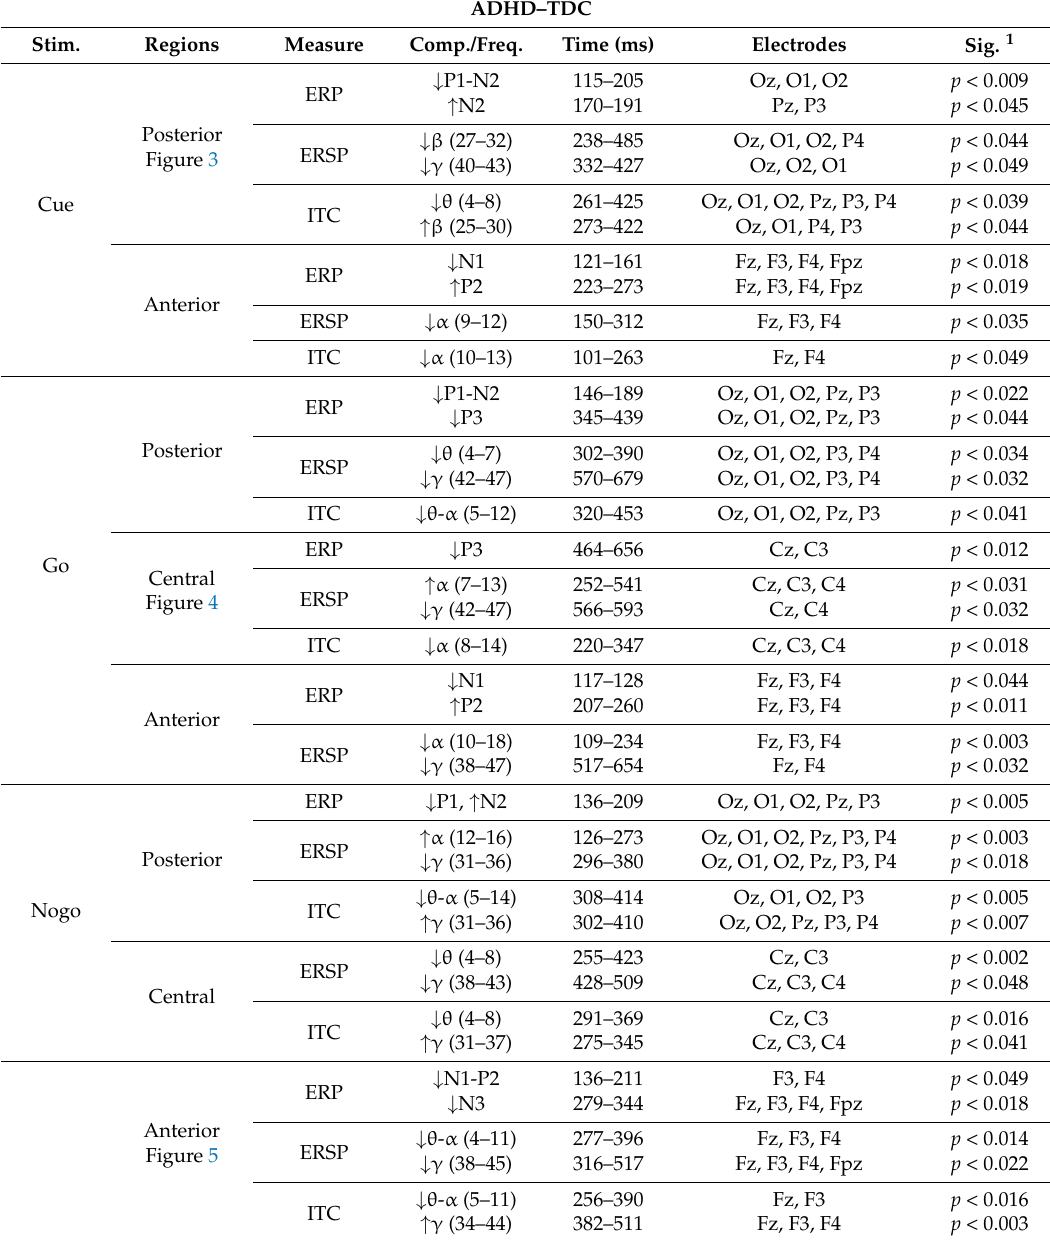
Table 2. Summary of results in children with ADHD compared to